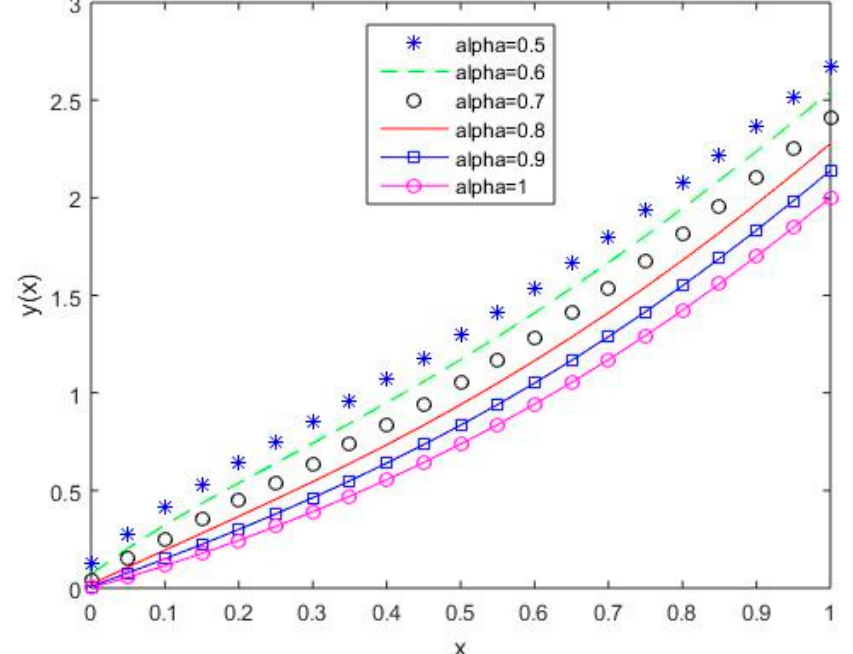
Figure 18. The behavior of solutions using S3 for 𝛼 values of 0.5, 0.6,0.7, 0.8, 0.9, and 1 , Example 2.